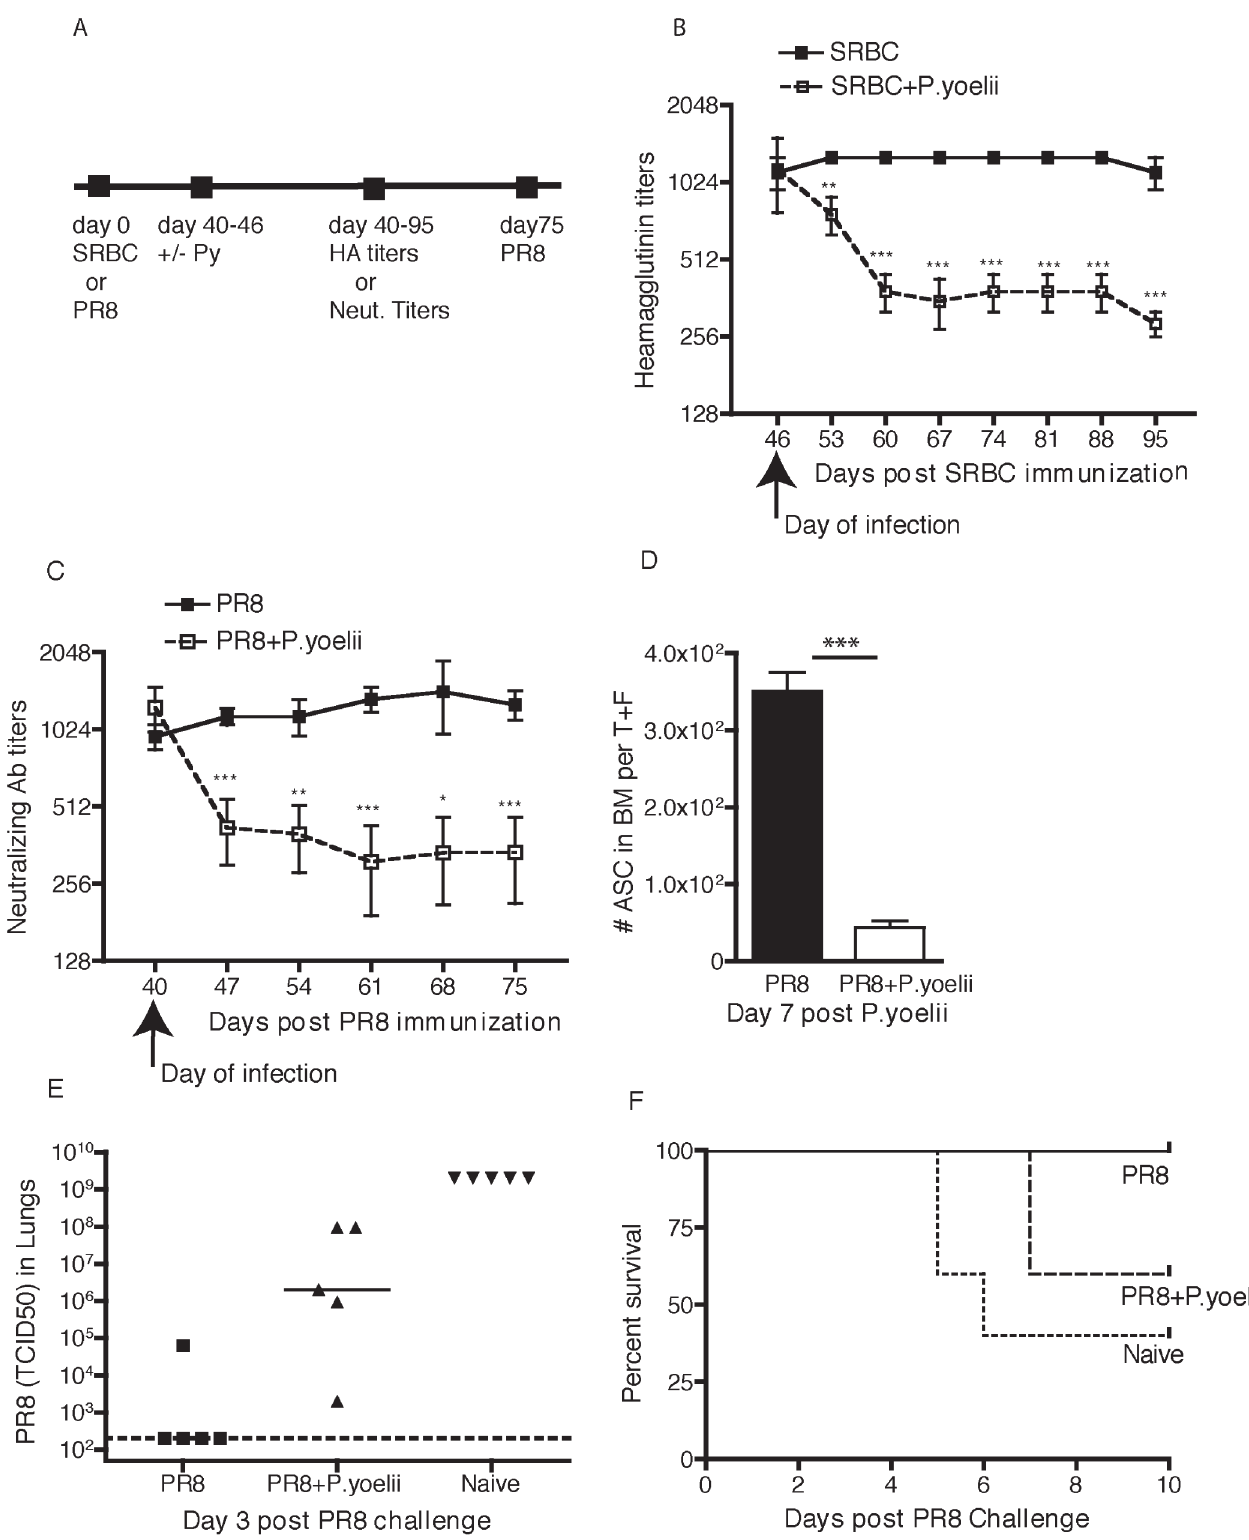
Fig 2. Decrease of preexisting antibodies after P . yoelii infection. A : Experimental design. BALB/c mice and outbred Swiss Webster mice were immunized with SRBC or received sublethal intranasal infection with PR8 IAV. At the indicated days post infection, some mice were infected with P . yoelii .